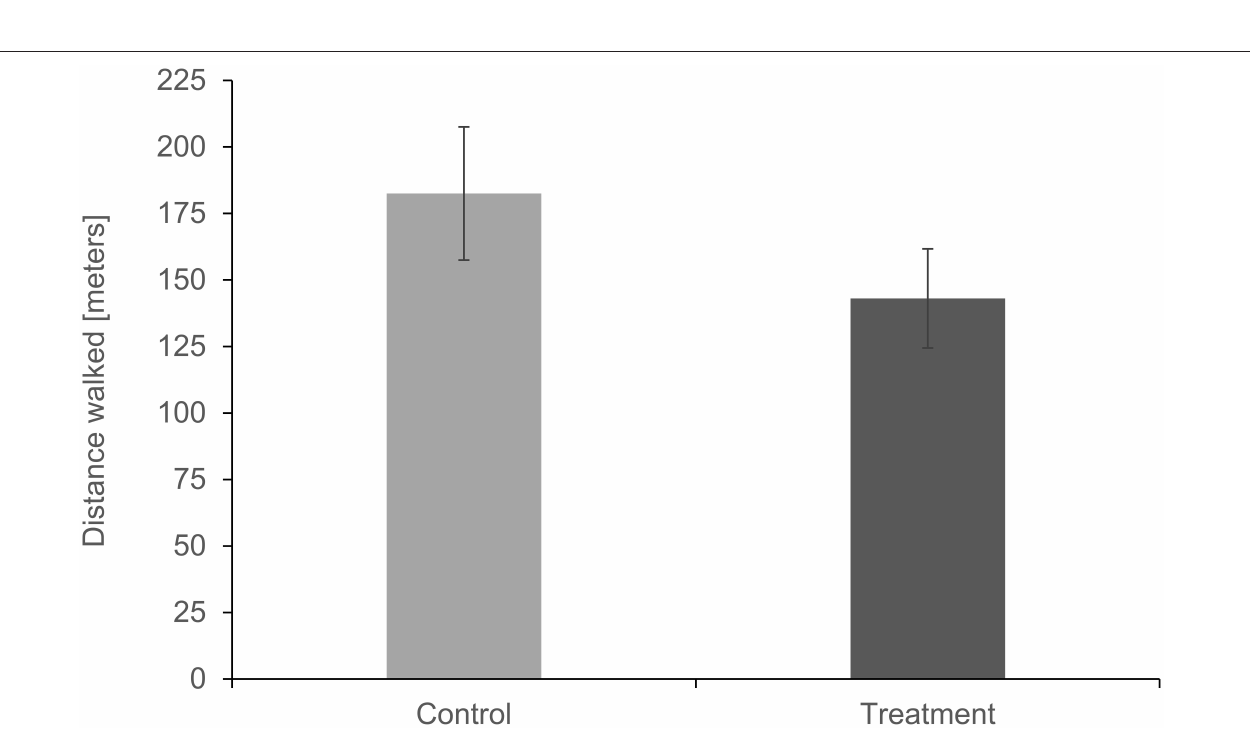
Frontiers in Virtual Reality |